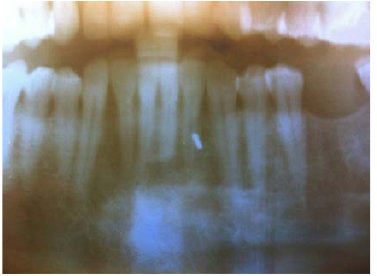
Figure 3. Panoramic X-ray.